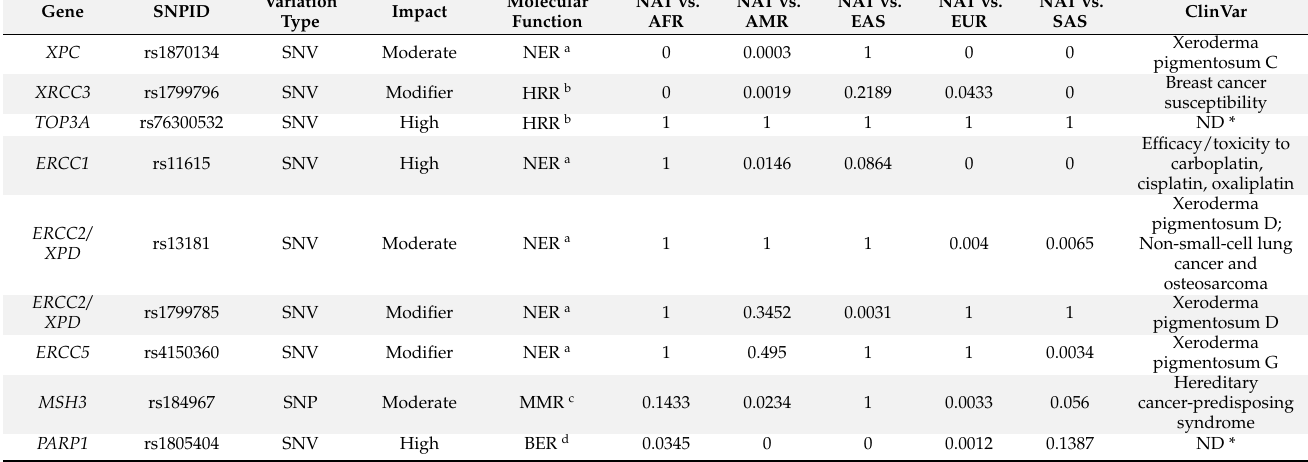
Table 2. Comparison between the allelic frequency of the study Native American populations (NAT) and five continental populations described in the gnomAD database for each variant investigated and their respective clinical impacts according to ClinVar.